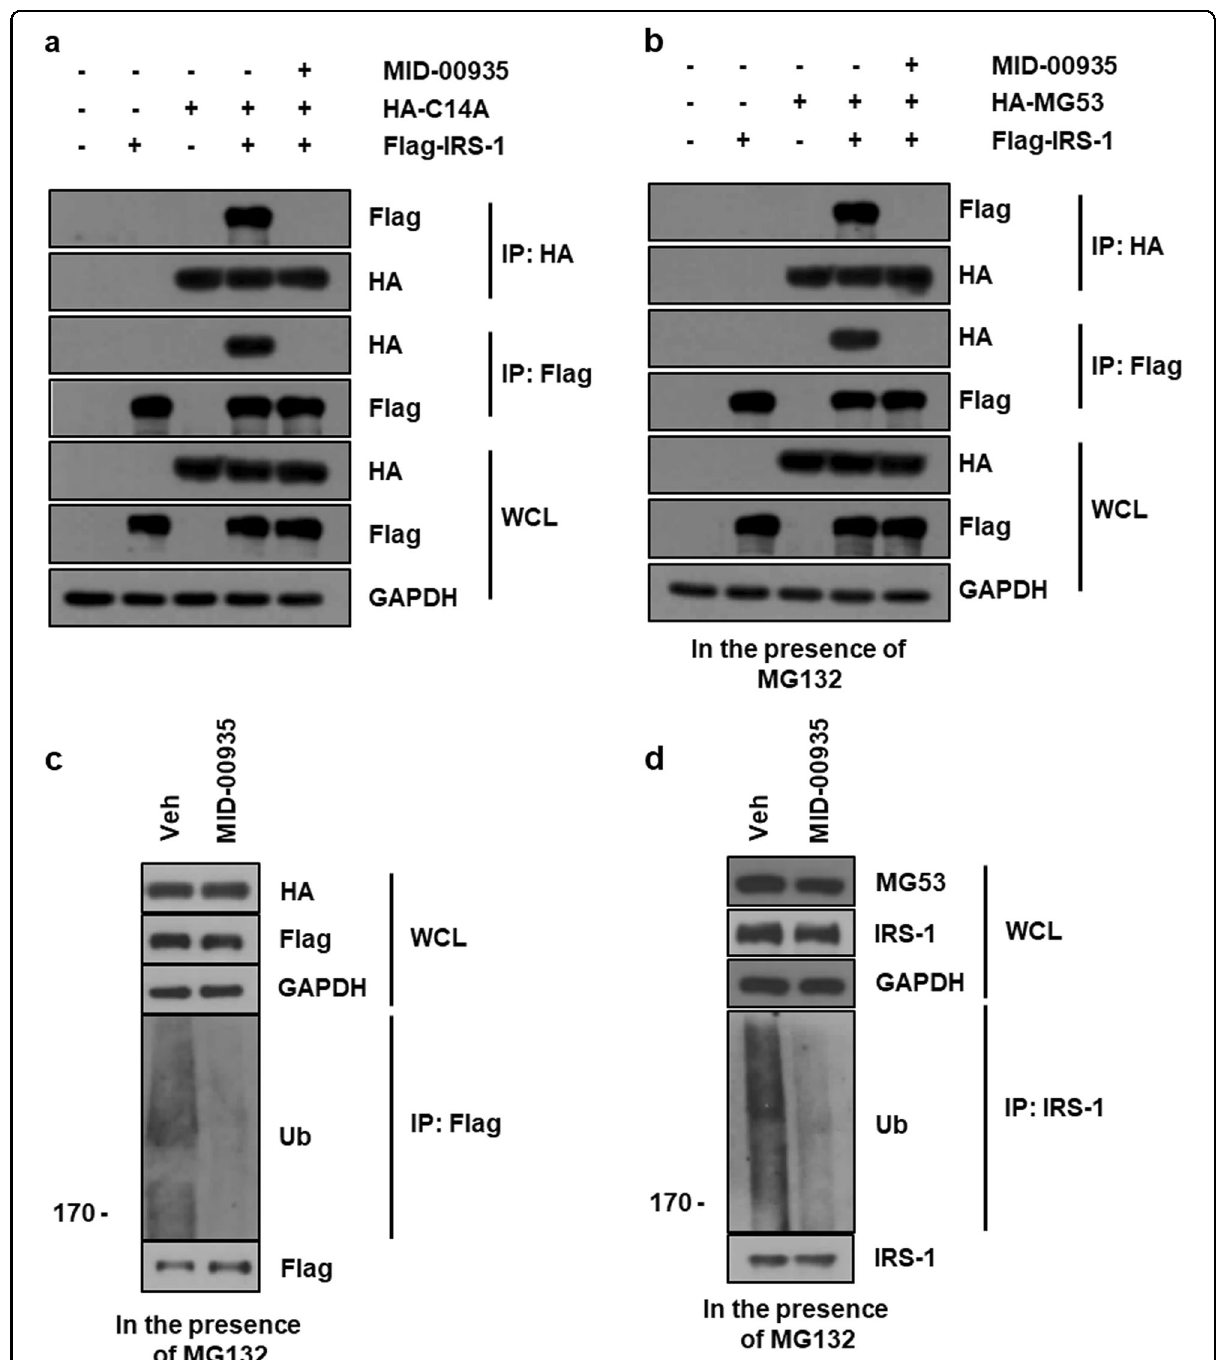
Fig. 2 MID-00935 interferes with the molecular interaction between MG53 and IRS-1. HEK 293 cells were transiently transfected with HA-MG53 C14A (C14A, 2.5 μ g) and Flag-IRS-1 (2.5 μ g) for 24 h and treated with or without MID-00935 (10 μ M) for 12 h. The molecular interaction between MG53 and IRS-1 was determined by reciprocal immunoprecipitation ( a ). HEK 293 cells were transiently transfected with HA-MG53 (2.5 μ g) and Flag- IRS-1 (2.5 μ g) for 24 h and treated with or without MID-00935 (10 μ M) in the presence of MG132 (2.5 μ M) for 12 h. The molecular interaction between MG53 and IRS-1 was investigated by reciprocal immunoprecipitation ( b ), and IRS-1 ubiquitination was evaluated by ubiquitin immunoblotting after Flag immunoprecipitation ( c ). Four-day differentiated C2C12 myotubes were treated with or without MID-00935 (10 μ M) in the presence of MG132 (2.5 μ M) for 12 h. IRS-1 ubiquitination was determined by ubiquitin immunoblotting after IRS-1 immunoprecipitation ( d